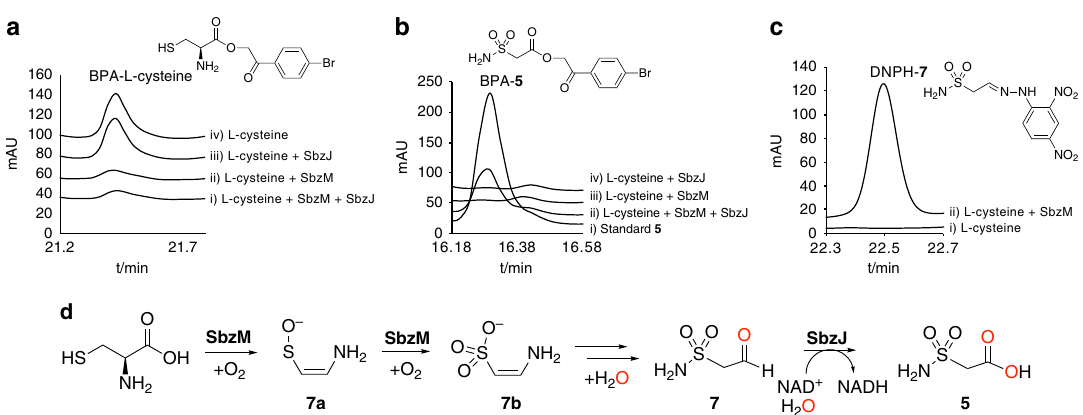
Fig. 4 HPLC analysis of the products of SbzM and SbzJ reactions. The substrate L-cysteine was derivatized with 4-bromophenacyl (4-BPA) bromide. a (i) SbzM + SbzJ, (ii) SbzM, (iii) SbzJ, and (iv) no enzyme, and the reaction products were derivatized with 4-BPA. b (i) Standard 5 , (ii) SbzM + SbzJ, (iii) SbzM, and (iv) SbzJ, or 2,4-dinitrophenylhydrazine (DNPH) hydrochloride. c (i) No enzyme and (ii) SbzM. The chromatogram represents the UV absorbance at 254 nm. d It was demonstrated that L-cysteine is converted into 2-sulfamoylacetic acid ( 5 ) by the collaboration of SbzM and SbzJ. In contrast, the cupin dioxygenase SbzM produces 2-sulfamoylacetic aldehyde ( 7 ) from L-cysteine via ( Z )-(2-aminovinyl)sulfanolate ( 7a ) and ( Z )-2- aminoethanone-1-sulfonate ( 7b ). The oxygens derived from water are colored